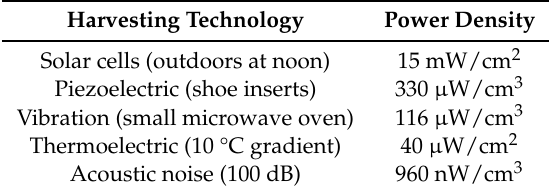
Table 1. Power density of environmental energy [12,36,42].